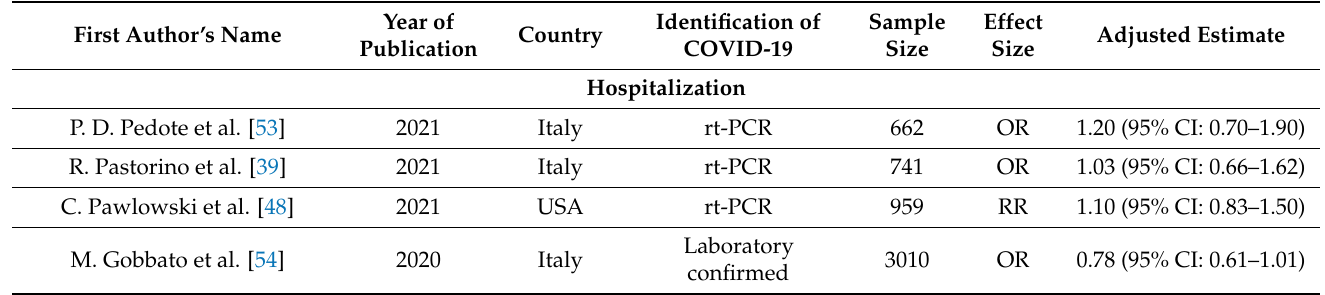
Table 2. Baseline characteristics of the 17 publications involving studies that assessed the association between influenza vaccination and COVID-19 clinical outcomes: (15 studies for hospitalization, four for Mechanical Ventilation/invasive respiratory support, 11 for Intensive care and 18 for